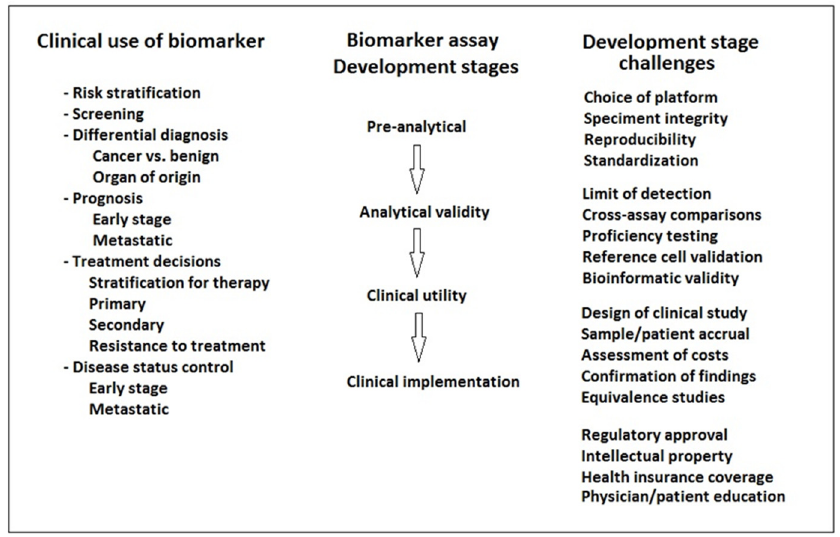
Figure 1. Steps in the implementation of liquid biopsy biomarkers for the detection of bladder can-